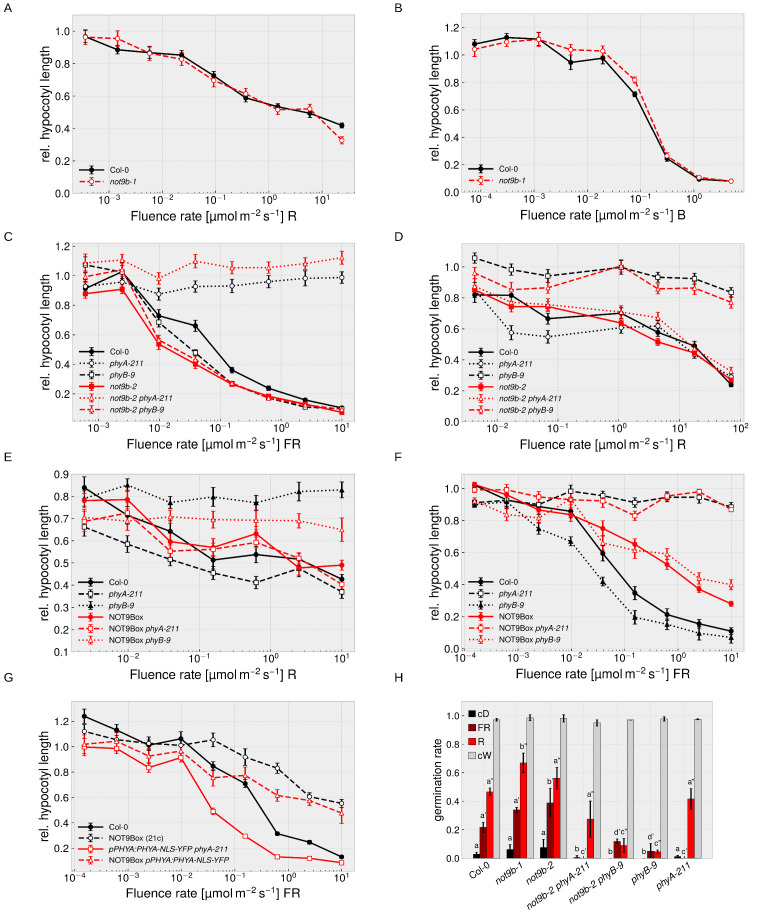
Fluence rate response curves for inhibition of hypocotyl growth and seed germination experiment.(A-G) Seedlings of the indicated genotypes were grown for four days at different fluence rates of FR, R, or B light or in the dark. Mean hypocotyl length (±SE) of 20 seedlings relative to dark-grown seedlings is shown. (A), (D), and (E) Seedlings were grown in R light. (B) Seedlings were grown in B light. (C), (F), and (G) Seedlings were grown in FR light. (H) Effect of NOT9B on seed germination. Seeds of indicated genotypes were imbibed on ½ MS, 2% agar and exposed to either R or FR light. After 5 days incubation in the dark, germination of >60 seeds per genotype and light condition was evaluated. Bars show mean seed germination rates of three biological replicates (± SD). Letters indicate levels of significance as determined by one-way ANOVA followed by post-hoc Tukeys HSD test: p<0.05.